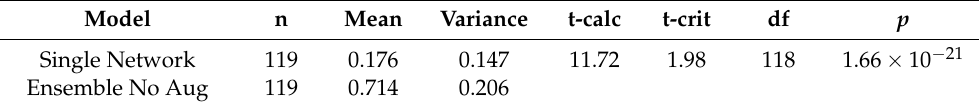
Table 2. Paired t -test Results Comparing Accuracy of Single Network vs. Ensemble with No Augmentation.